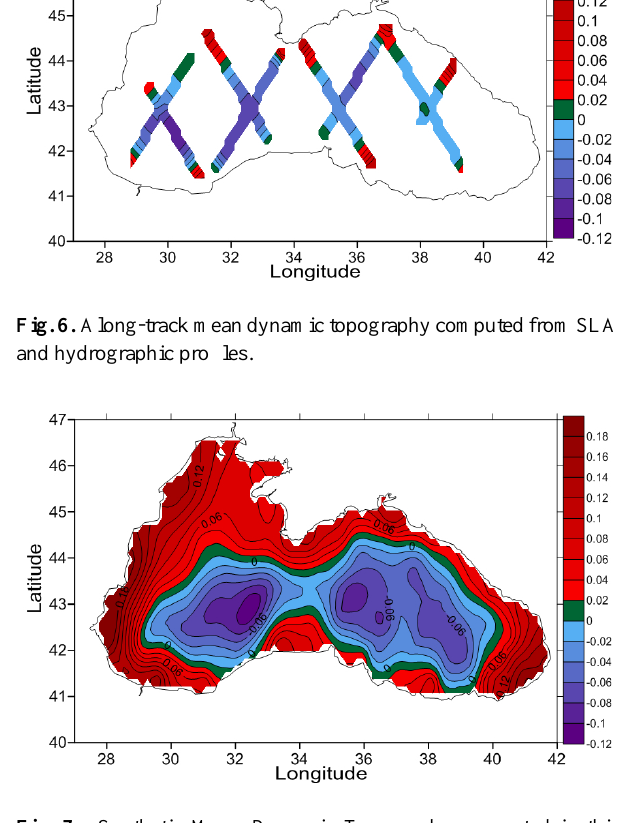
Fig. 7. Synthetic Mean Dynamic Topography computed in this